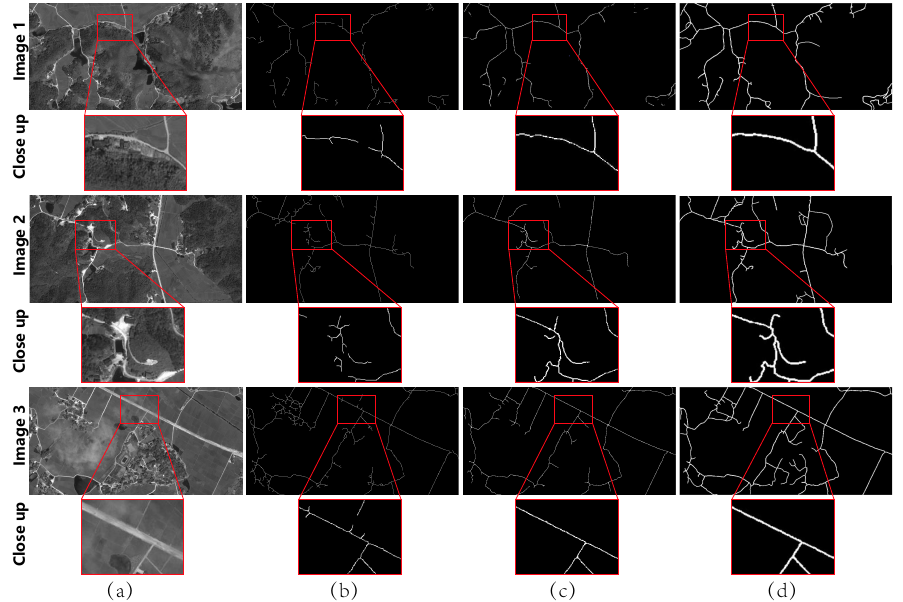
Figure 7. Visualized results of typical examples on Shaoshan dataset: ( a ) original image; ( b ) result of the ScGAN; ( c ) result of McGAN; and ( d ) ground